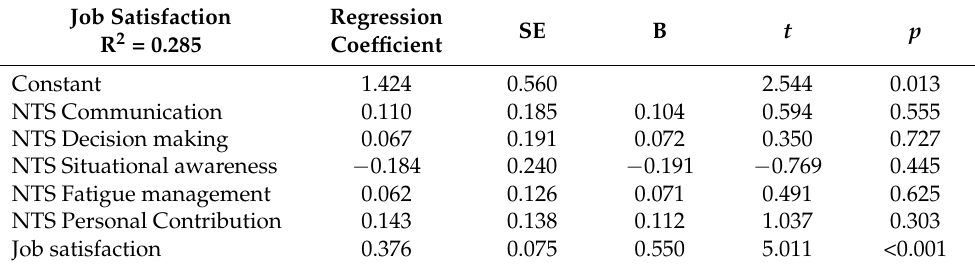
Table 6. Model 4—NTS, Multiple linear regression for physicians’ mental well-being ( n = 78). Job